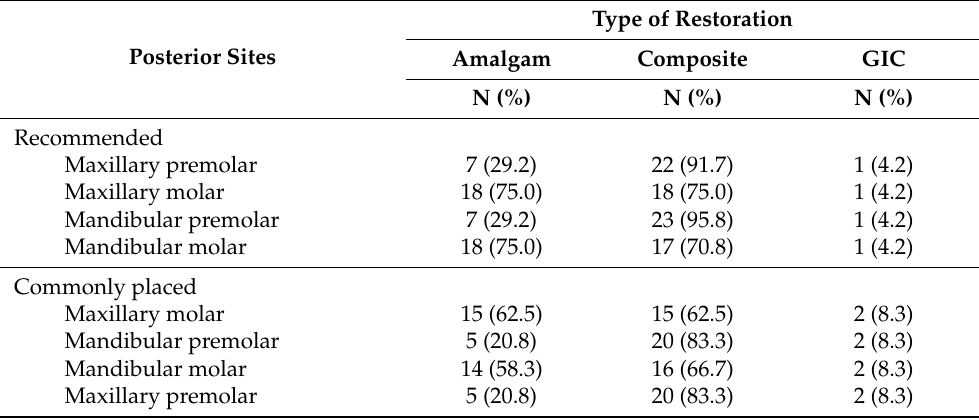
Table 4. Restorative materials taught for posterior tooth ( n =